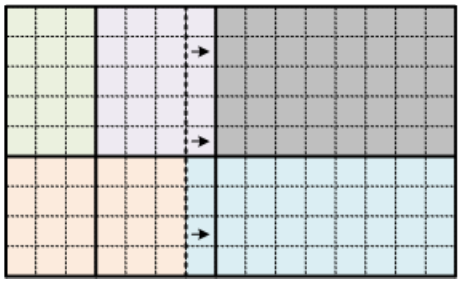
Figure 5. Example of proposed Adjusted Slice-oriented partitioning (5 subpictures, 6 tiles, 6